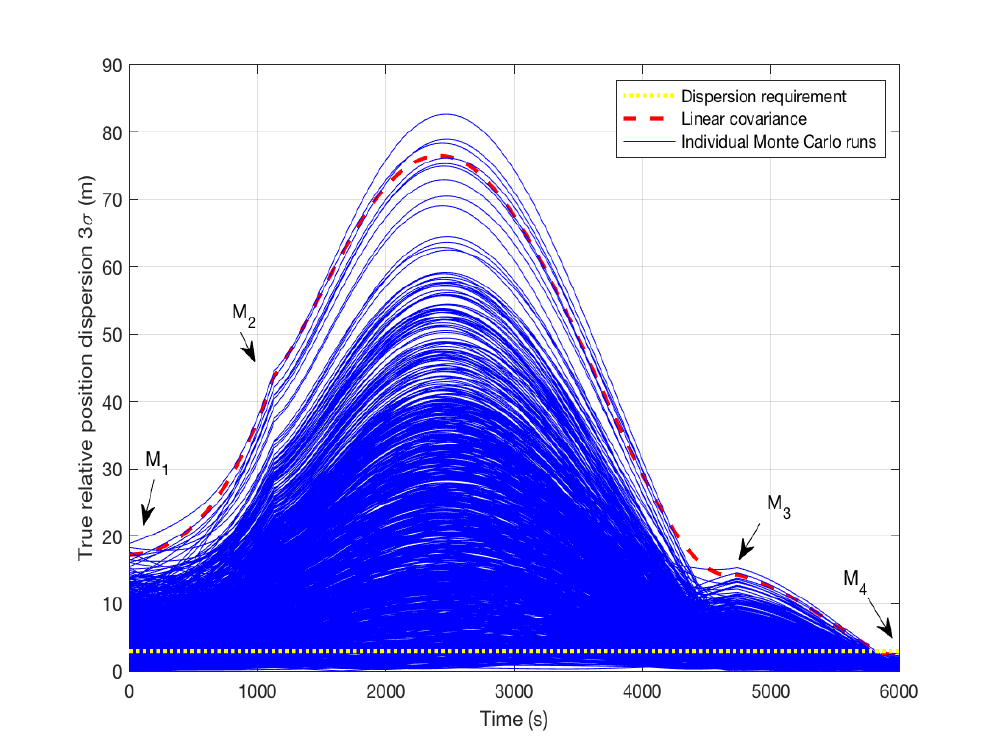
Figure 8. Monte Carlo analysis for high-cost system when t f = 6000 s.